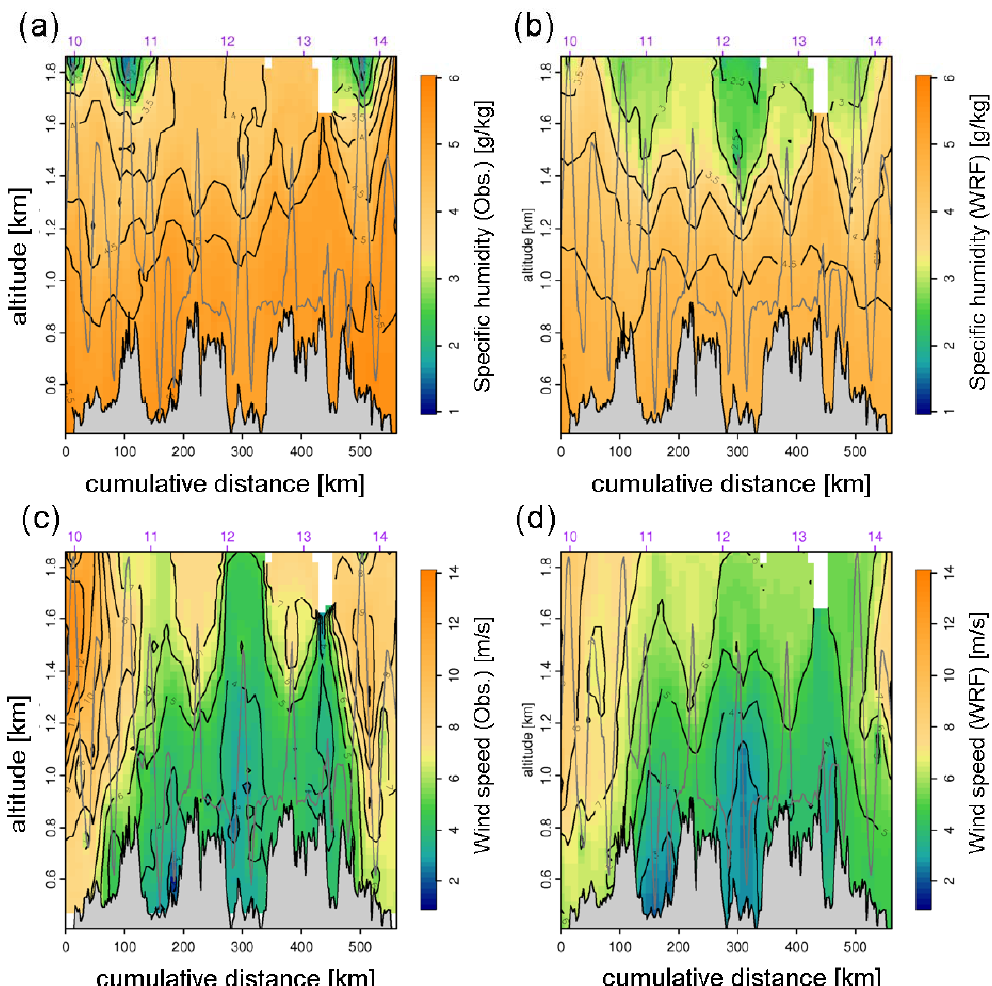
Figure 5. Vertical cross section (using a distance weighted interpolation) of the observed and simulated meteorological fields as a function of distance flown by the aircraft for 19 October 2008: (a–b) specific humidity in gkg − 1 (c–d) Wind speed in ms − 1 . (a) and (c) represent measurements and (b) and (d) represent WRF simulations. The grey lines indicate flight track and the shaded grey region represents terrain elevation. See Fig. 7d for aircraft track showing altitude above ground. Time of the measurements/simulations is given in the top x-axis.